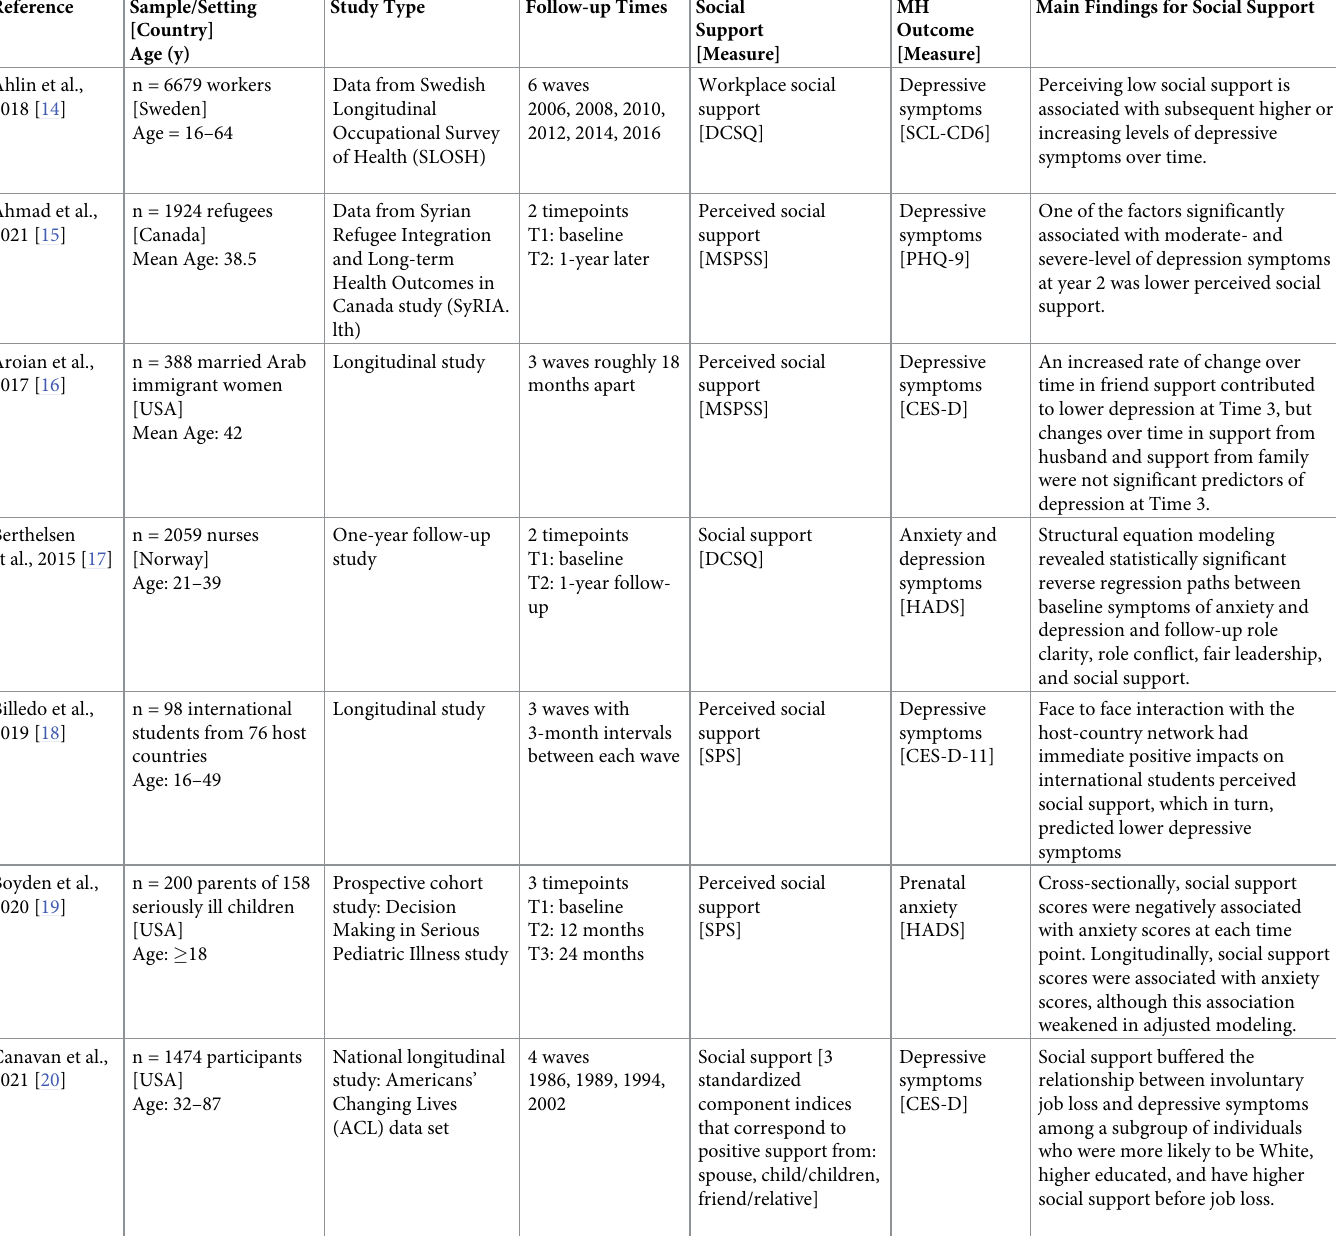
Table 1. a. Characteristics of included studies on social support for nonpregnant samples. b. Characteristics of included studies on social support for pregnant